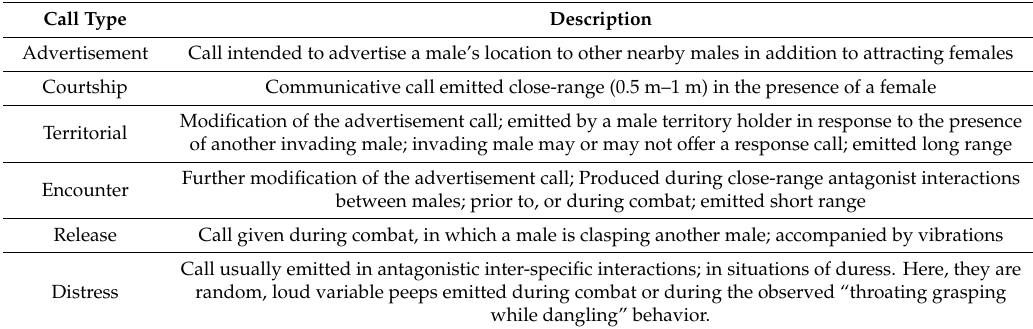
Table 5. Call types and associated behaviors described for Nymphargus grandisonae [51]. Definitions follow Bogert [258], Duellman and Trueb [259], and McDiarmid and Adler [238].